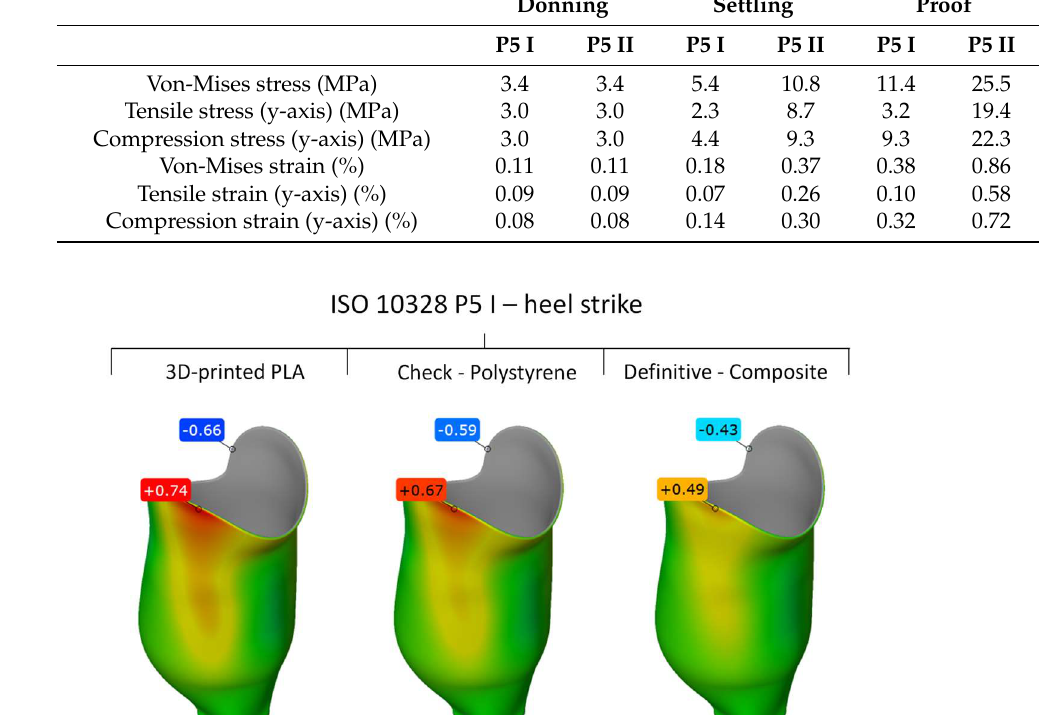
Table 4. Summary of maximum stress and stain numerical results for all loading conditions.